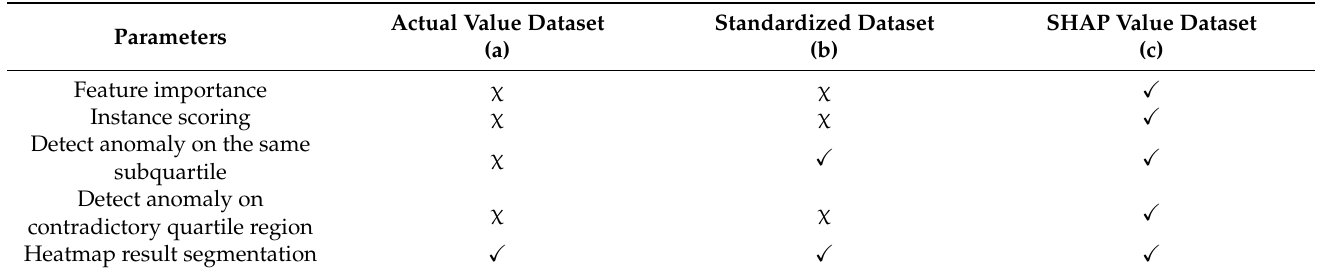
Table 4. Comparison of framework performance based on the